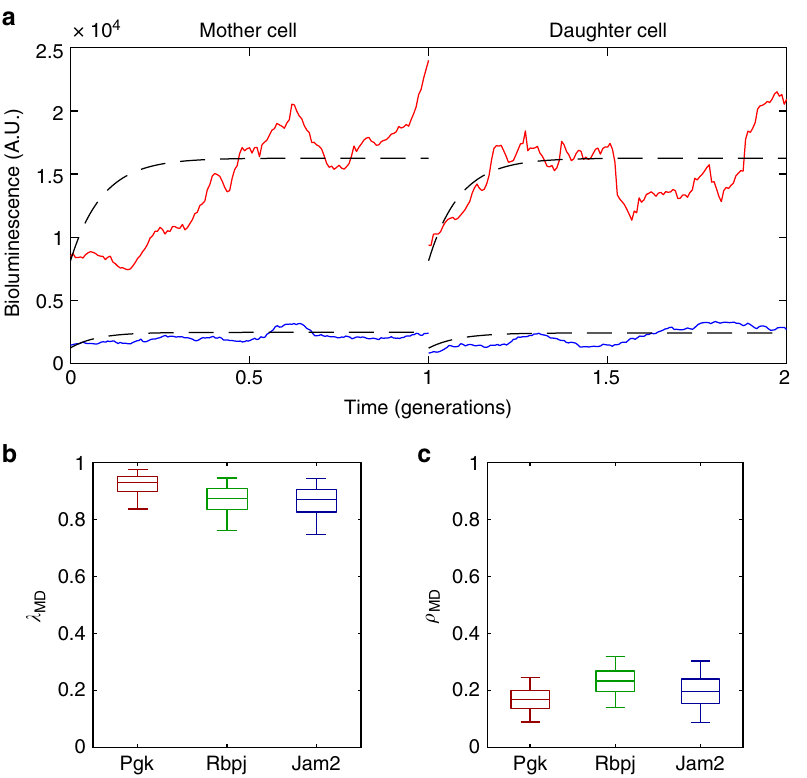
Fig. 5 Highly correlated transcriptional activities between mother and daughter cells. a Examples of two pairs of mother and daughter cells from the pGK gene. Red and blue represent different pairs of cells. b Posterior distribution (shown as boxplots) of the correlation of mean transcriptional levels ( λ MD ) between mother and daughter cells. The box represents the 25th, median (50th) and 75th percentiles of the posterior distributions and the whiskers represent the 5th and 95th percentiles. c Inferred posterior probability distribution of the similarity in dynamics ( ρ MD ) between mother and daughter